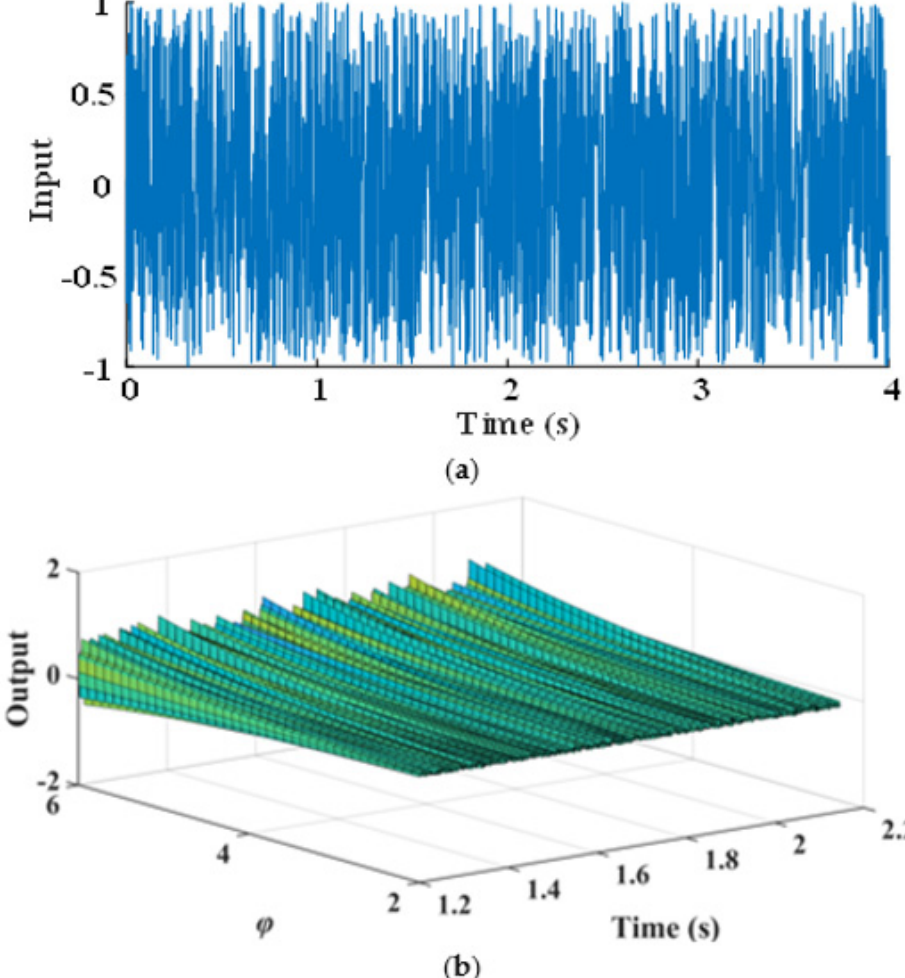
Figure 6. The WEFOR output predict by MPO of φ = [2:0.5:6]. ( a ) System input and ( b ) system output.